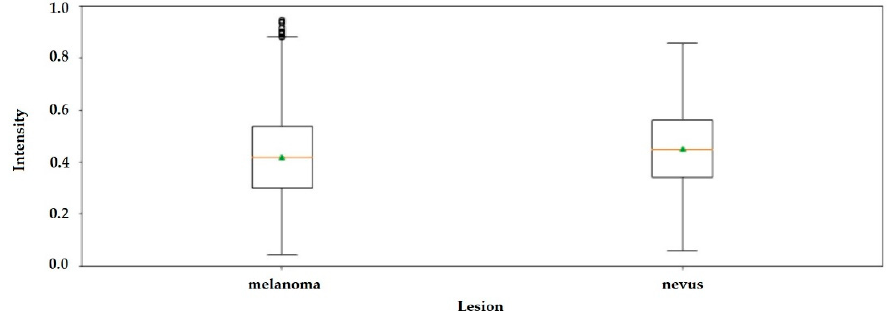
Figure 4. Boxplot with average intensities of grayscale images with melanoma and nevus. Performance Metrics for Classifiers